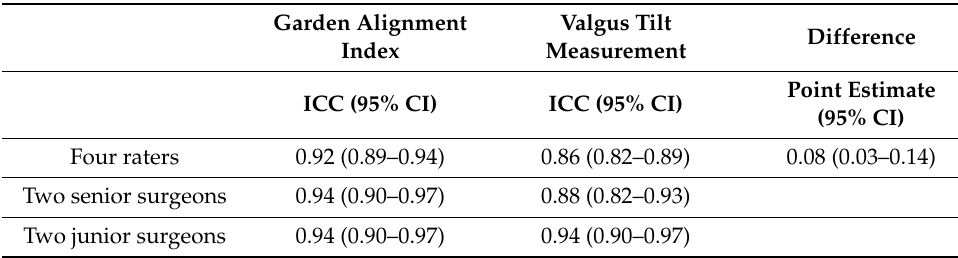
Table 1. Intra-rater reliability of the Garden alignment index and valgus tilt measurement for four raters in 50 hip radiographs.